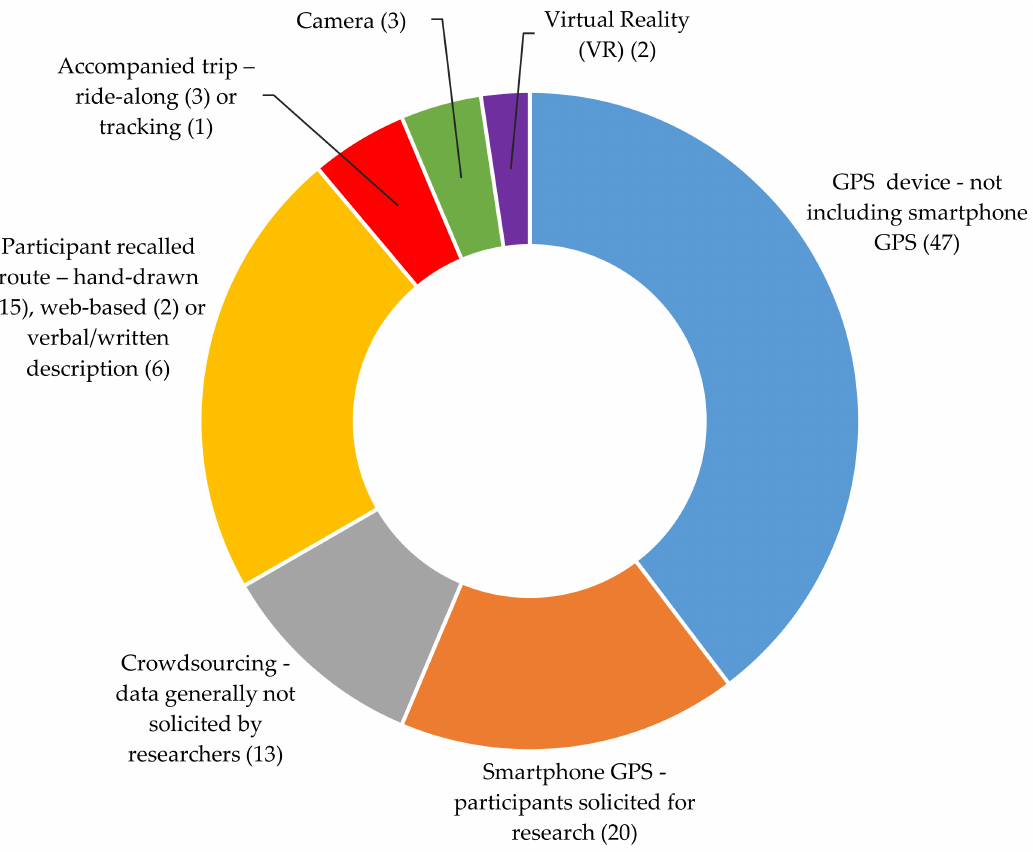
Figure 2. Seven method families for categorisation of the literature (numbers of articles in